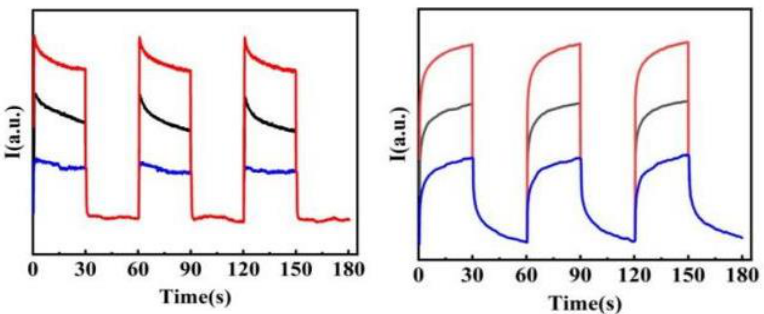
Figure 9. Transient photocurrent response of the film [PDDA/Ni25] n ( n = 1, 3, 5) ( left ) and the film PDDA/[Ni25/(PDDA − rGO)] n ( n = 1, 3, 5) ( right ) at 1.0 V vs. time (i − t) curve with a 30 s light on/off.